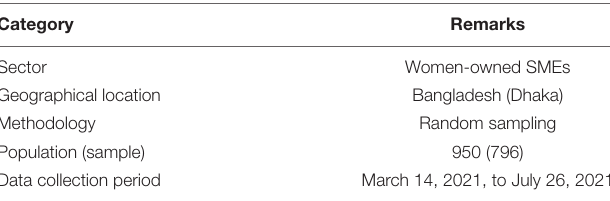
TABLE 1 | Technical details for research